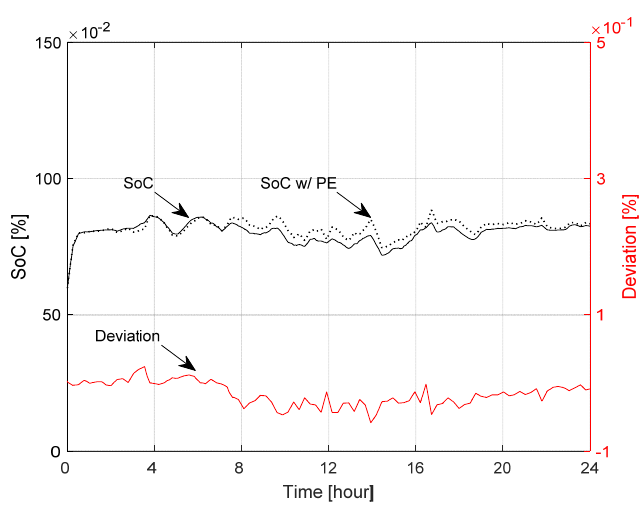
Figure 7. SOC comparison between two cases.